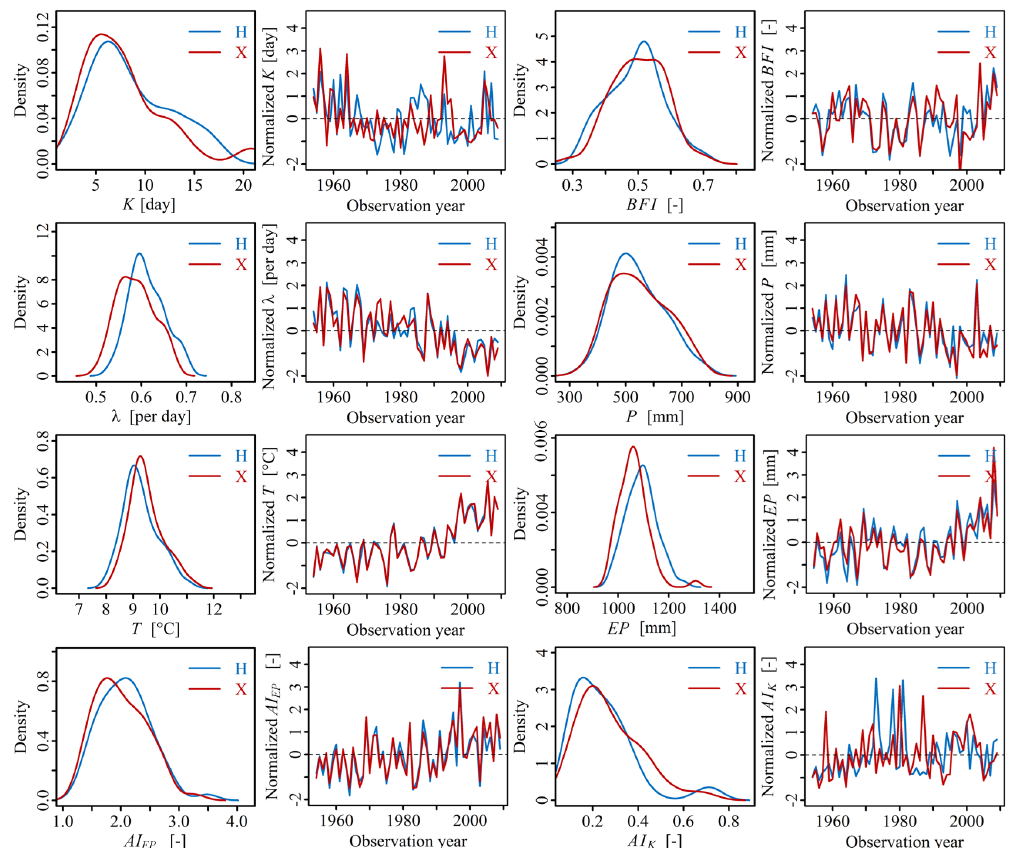
Figure 4. Frequency distributions (using the kernel density estimations) and time series processes of TCCCs variables in both Huaxian (H) and Xianyang (X)